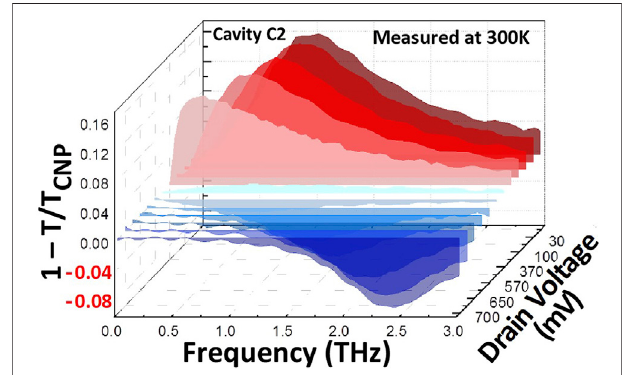
FIGURE 3 | Drain bias – dependent extinction spectra of the graphene structures. Spectra measured in cavity C2 of device A-DGG1 for fi xed V g2 −